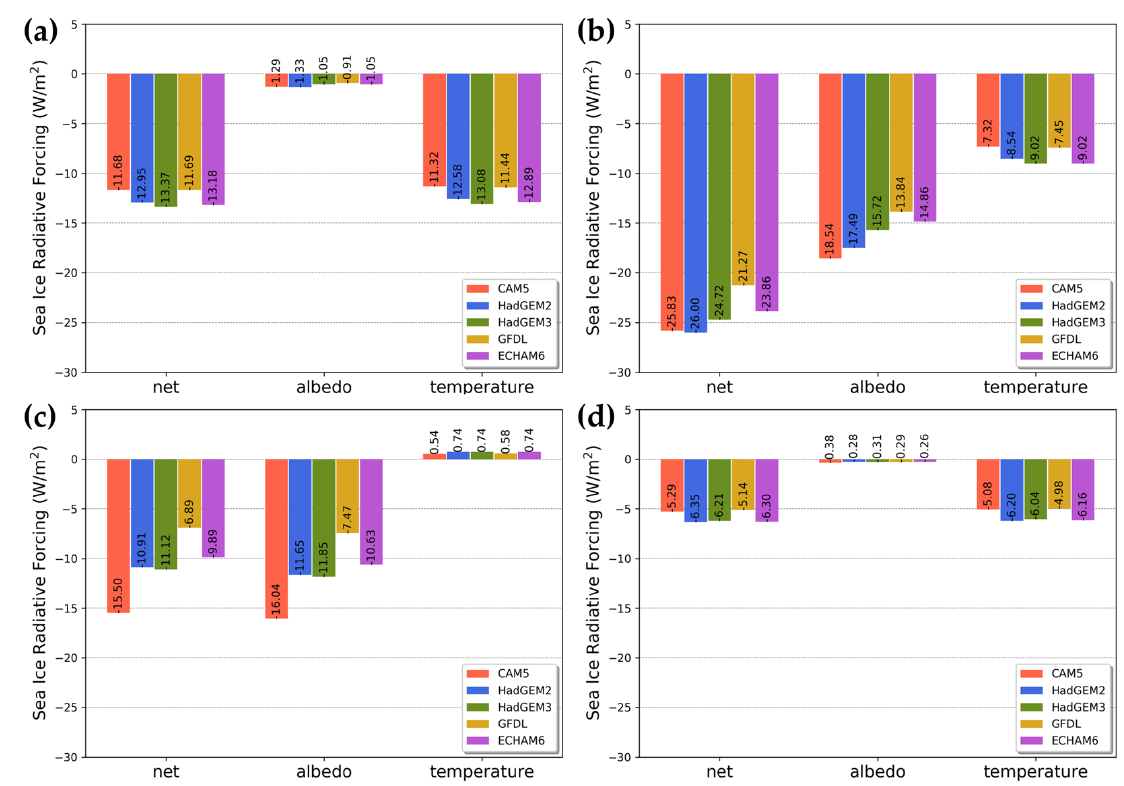
Figure 5. The seasonal average SIRFs according to GCMs. ( a ) December − January − February period, ( b ) March − April − May period, ( c ) June − July − August period, ( d ) September − October − November period.